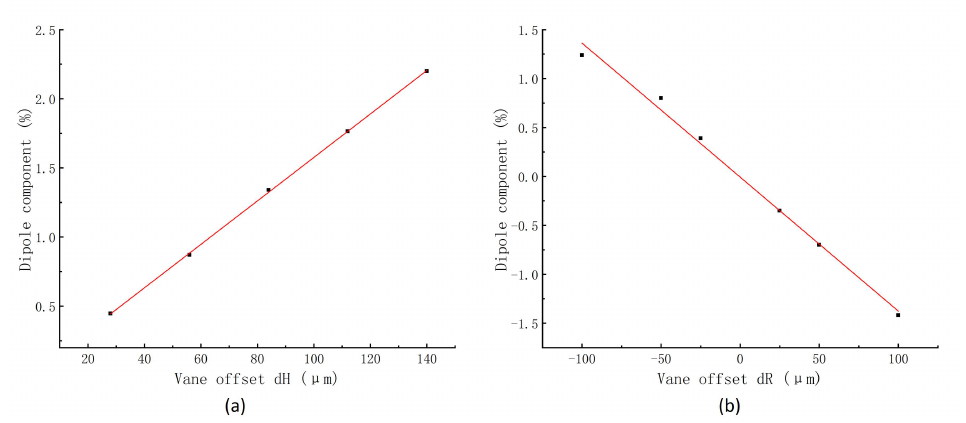
Figure 15. Dipole field components caused by structural errors. ( a ) Dipole field component caused by vane offset dH, ( b ) Dipole field component caused by vane offset